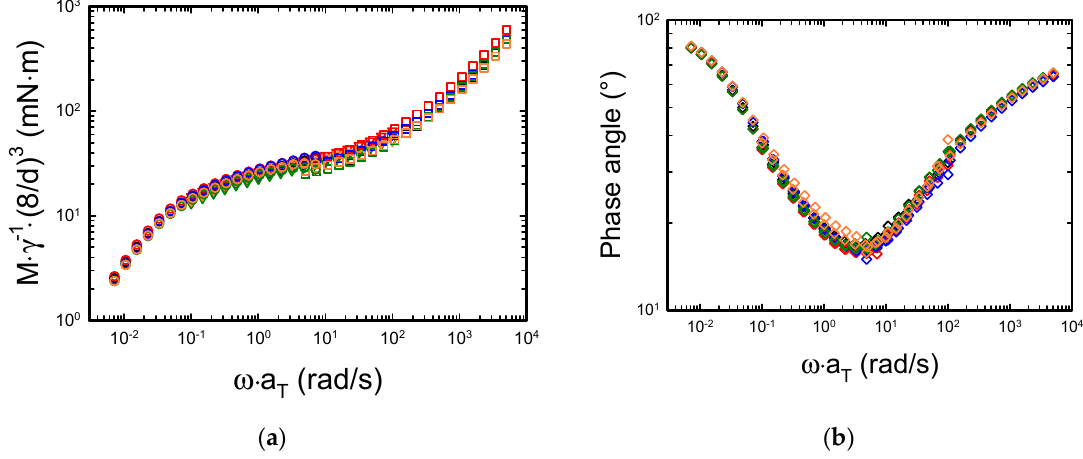
Figure 4. ( a ) Torque and ( b ) phase angle mastercurves. The color legend is the same as in Figure 2.